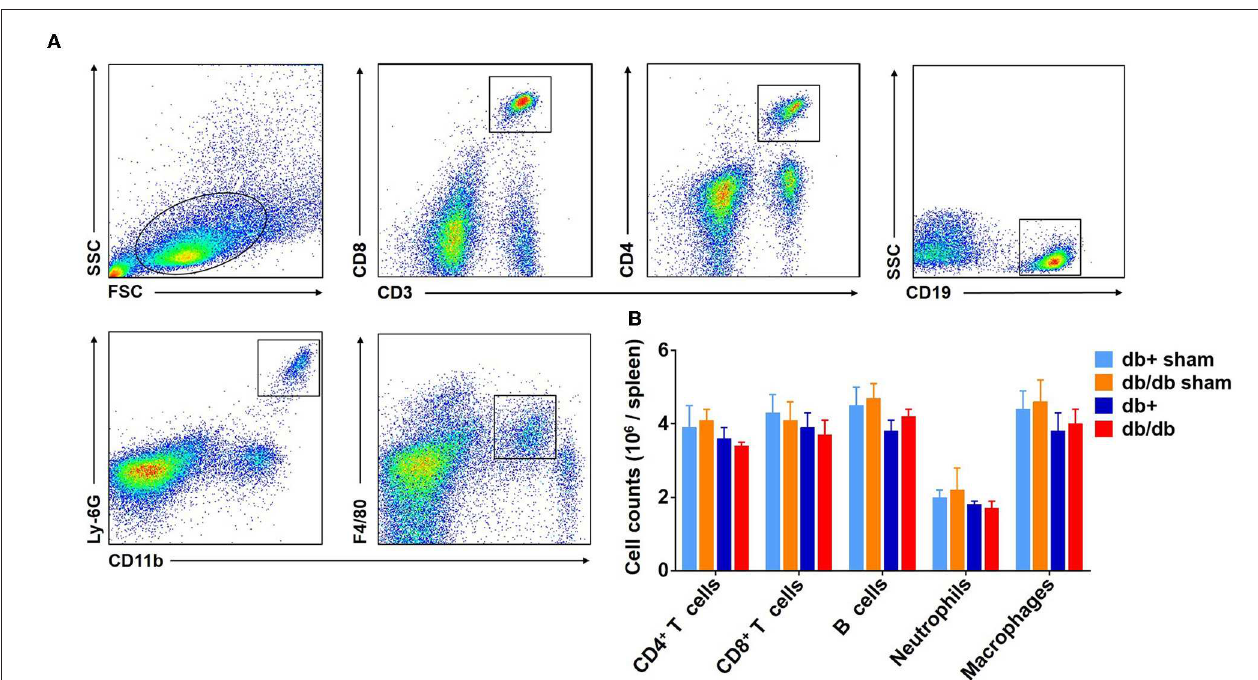
FIGURE 4 | Counts of splenic leucocytes in db/db and db/ + mice following brain ischemia. The counts of splenic leucocyte subsets were measured at 3 days after dMCAO in groups of db/db and db/ + mice by flow cytometry (A) . Gating strategy of macrophages (CD11b + F4/80 + , M ϕ ), neutrophils (CD11b + Ly-6G + ), CD4 + T (CD3 + CD4 + ), CD8 + T (CD3 + CD8 + ), and B (CD19 + ) cells in the spleen at day 3 after dMCAO. (B) Quantification of splenic lymphocytes, macrophages and neutrophils in indicated groups of db/ + and db/db mice. Data are expressed as mean ± s.e.m, n = 8 per